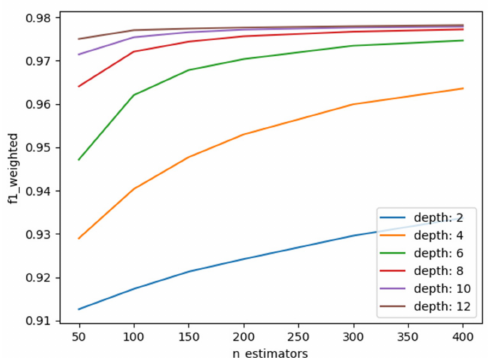
Figure 8. The plot of results of the optimal ‘max_depth’ and ‘n_estimators’ parameters according to the F1-weighted score for the experimental dataset in XGBoost.